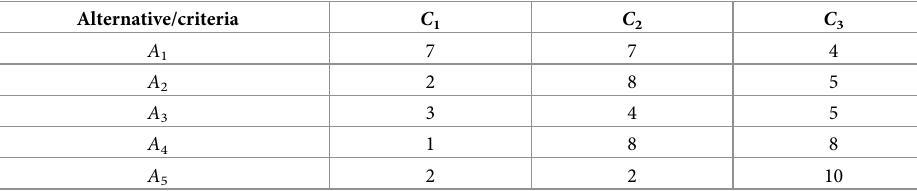
Fig 1. Monte Carlo weights method. https://doi.org/10.1371/journal.pone.0268950.g001 Table 1. The decision matrix: The evaluation of alternatives with respect to criteria.